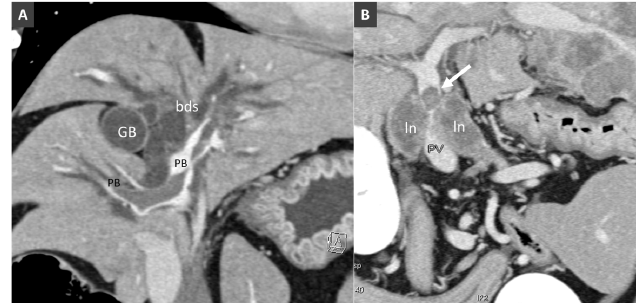
Figure 7. A . Dorsal MPR (multiplanar reformation) view of the liver in a dog with suppurative hepatitis (ln, lymph node). B . Dorsal MPR view in another dog. Note the large filling defect in the portal branches (PB) within the liver. Biliary ducts (bds) are enlarged gallbladder (GB).